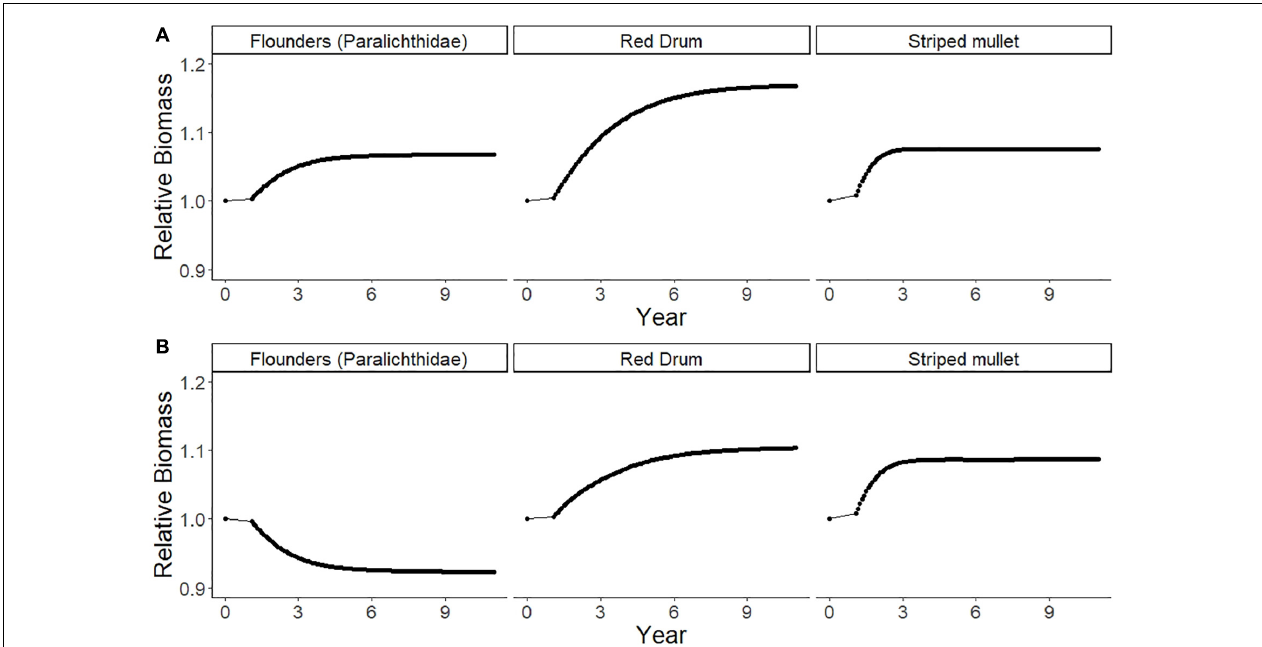
FIGURE 10 | The predicted relative biomass values of paralichthyid flounders, red drum, and striped mullet for ten years following a gill net ban with: (A) ECOSIM model Scenario 1, no gear-switching or fishing effort re-distribution to other gears; (B) ECOSIM model Scenario 2, Gill Net Ban with Increased Effort in Alternative Fisheries (pound netting, haul seining, shrimp trawling, skimmer trawling, and crab potting) after gear-switching based on the relative fishing effort (RFE, Table 5 ) derived from the fisher behavioral network after gill net